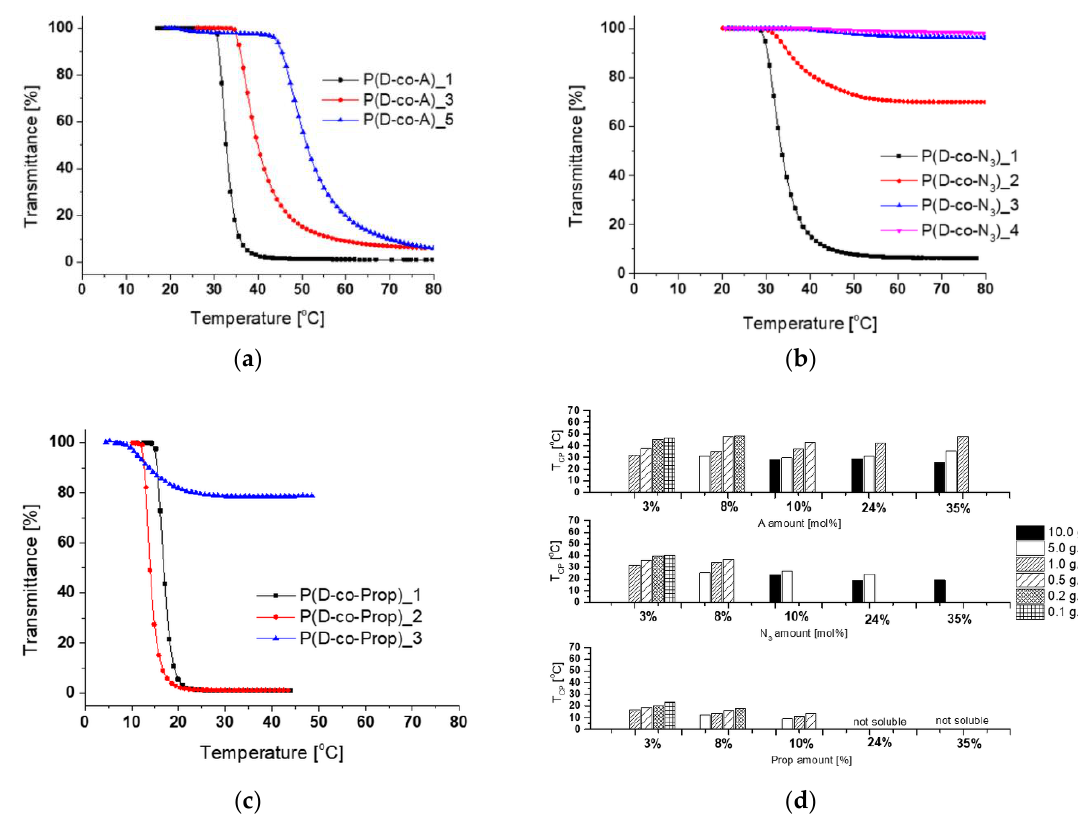
Figure 3. Transmittance versus temperature for ( a ) P(D-co-A)_1, P(D-co-A)_3, P(D-co-A)_5, ( b ) P(D-co-N 3 )_1, P(D-co-N 3 )_2, P(D-co-N 3 )_3, P(D-co-N 3 )_4, ( c ) P(D-co-Prop)_1, P(D-co-Prop)_2, P(D-co-Prop)_3 in water at a concentration of 1.0 g/L and ( d ) summary of phase transition temperatures for concentrations of 10.0, 5.0, 1.0, 0.5, 0.2, and 0.1 g/L of all polymers before and after modifications.